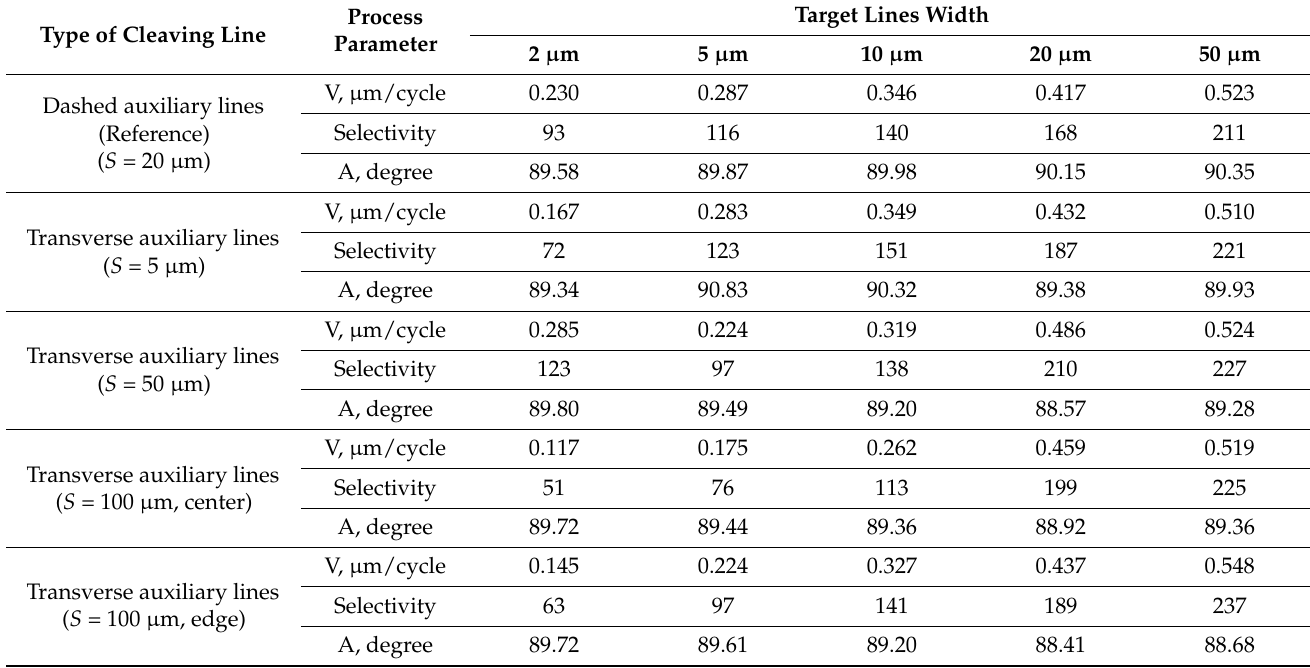
Table 4. Deep etching experimental results for target microstructures with aspect ratio W:D =